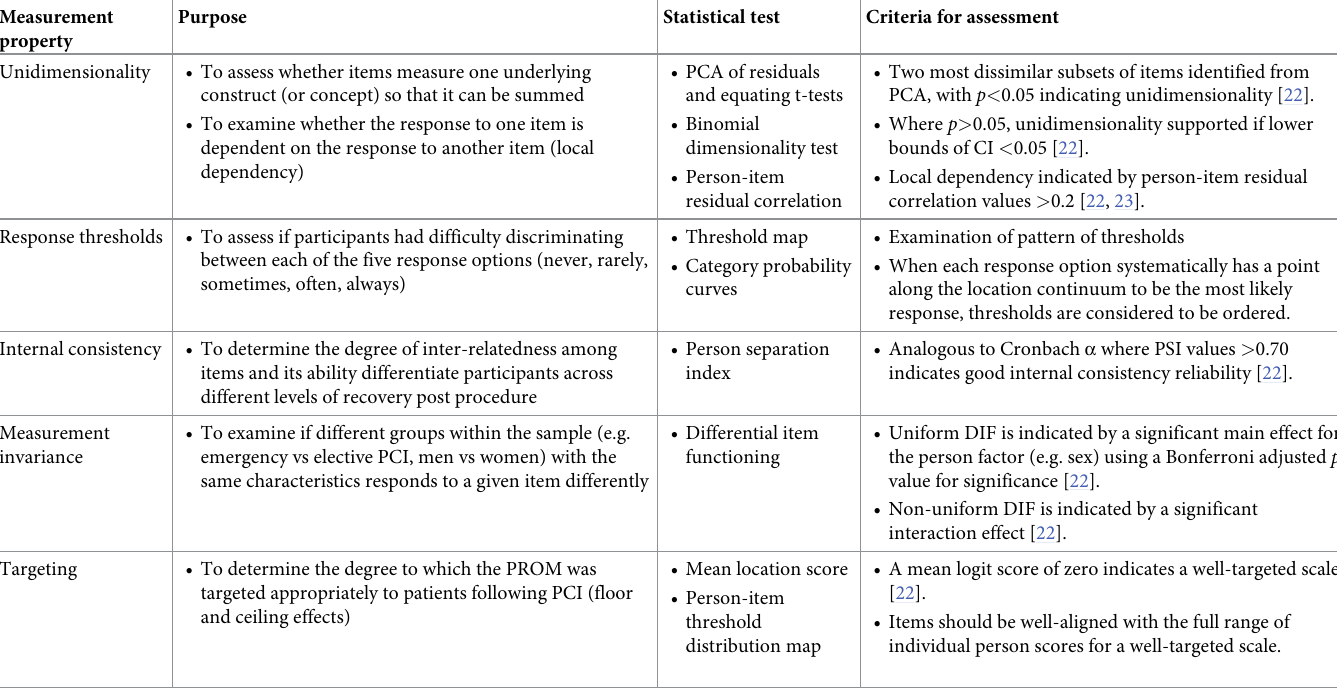
Table 1. Methods and criteria to examine key measurement properties of the items generated from previous studies [23–25]. Measurement